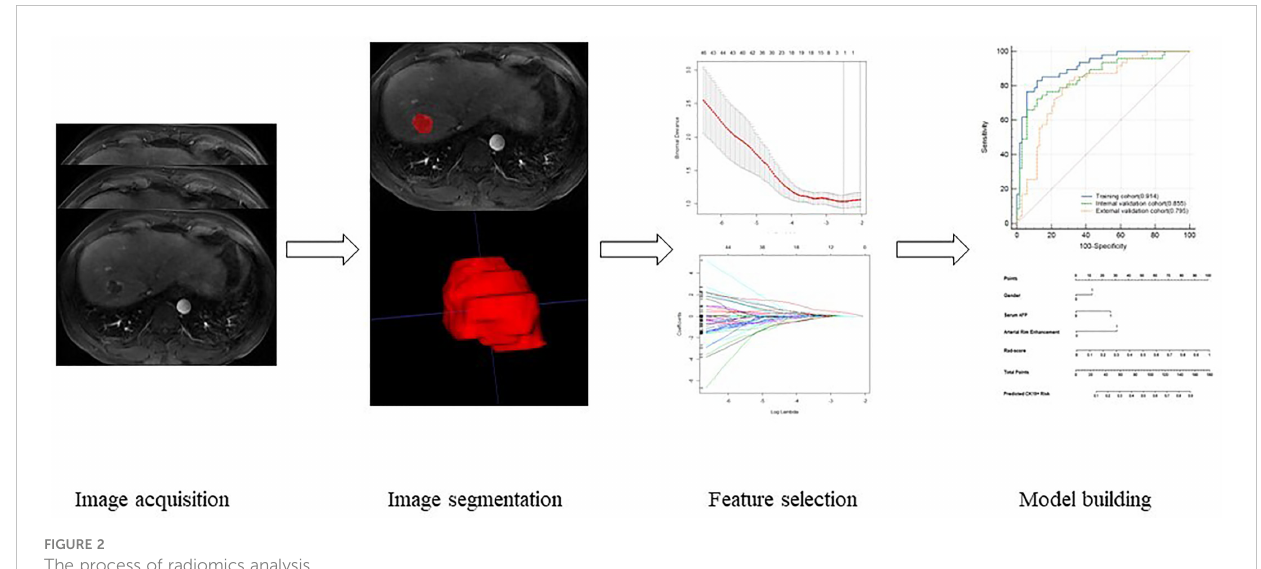
FIGURE 2 The process of radiomics